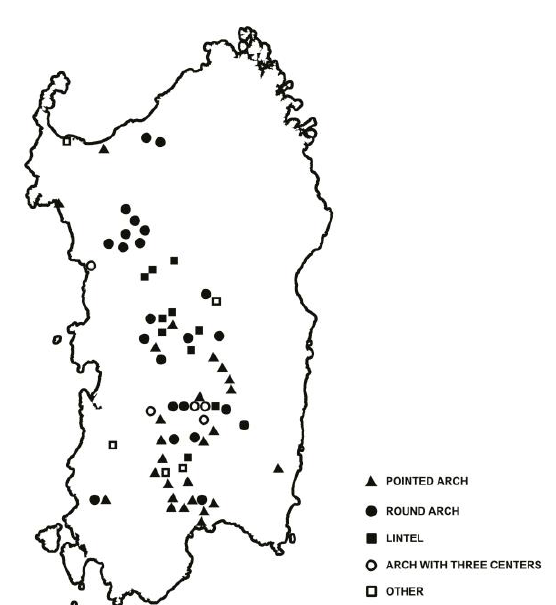
Figure 1. Location of the portals, distinct according to the geometric shape.